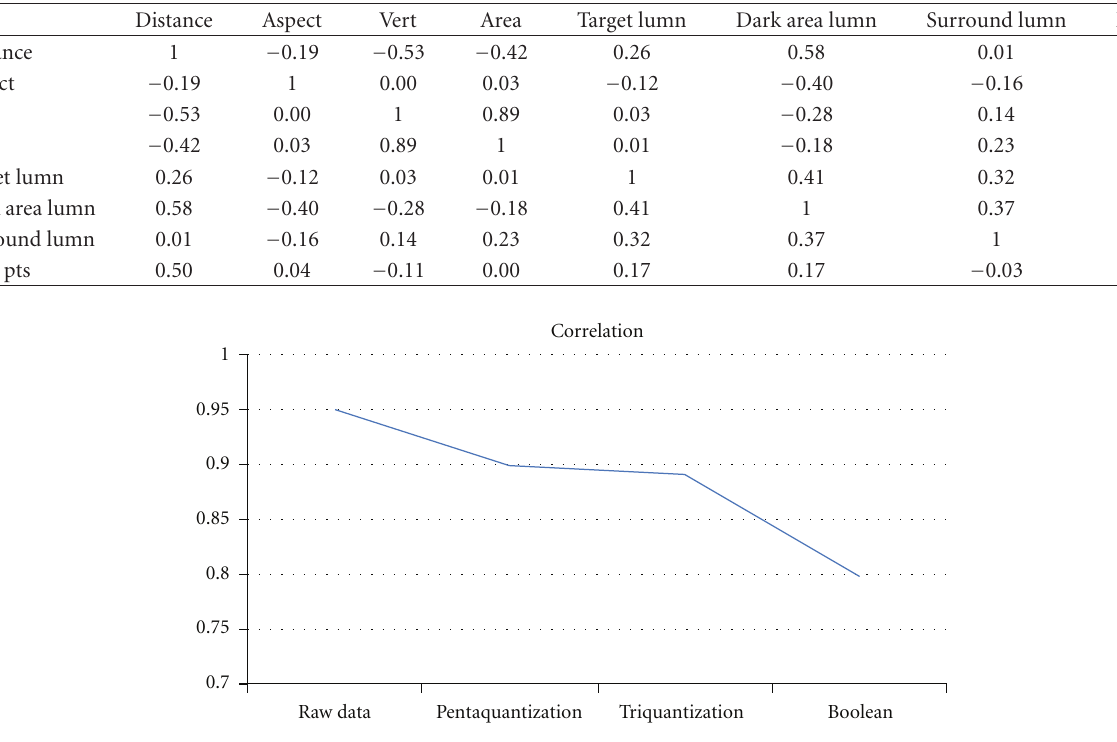
Table 9: MiniTab correlation of trilevel quantized data.